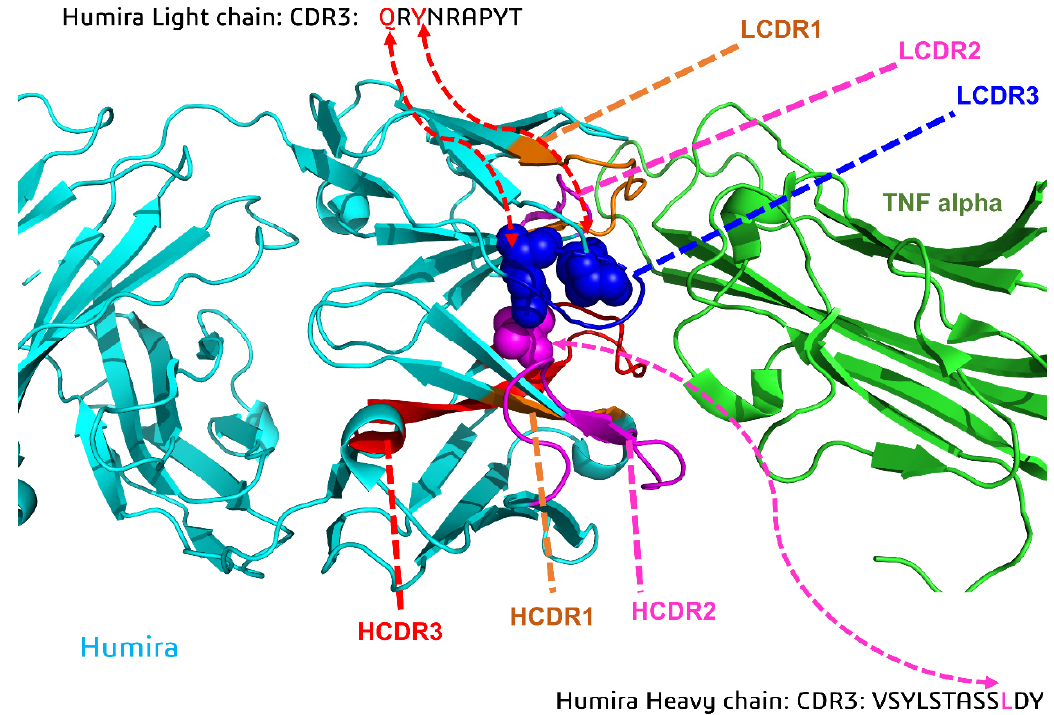
Figure 1. Overview of the key CDR (light and heavy complementarity-determining region 3, HCDR3, and LCDR3) positions replaced with histidine residues (W1-Humira).